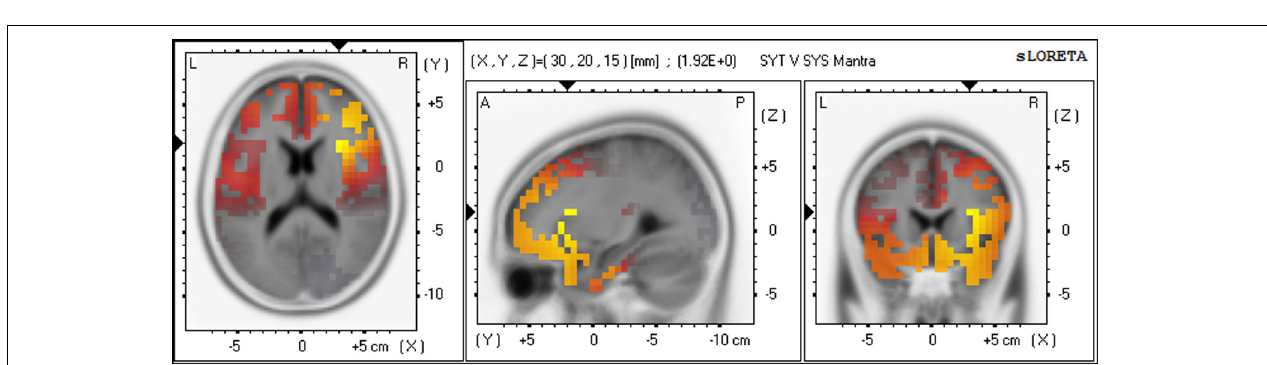
FIGURE 6 | Differences in CSD between groups in gamma band in Meditation 2 (Mantra) Increased gamma activity (yellow) in SYT compared to SYS in right BA13 (insula).